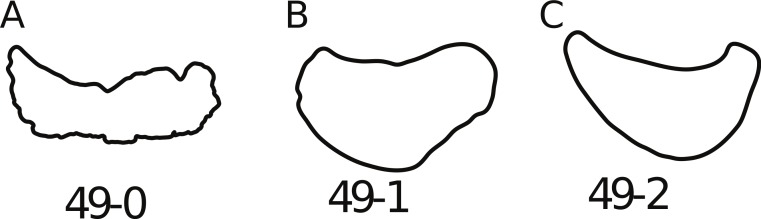
Articular surfaces of neosauropod quadrates.Quadrate articular surface shapes of Camarasaurus sp. SMA 0002 (A, quadrangular, C49-0), Suuwassea emilieae ANS 21122 (B, roughly triangular, C49-1), and Nigersaurus taqueti MNN GAD512-7 (C, crescent-shaped, C49-2). Figures of Suuwassea and Nigersaurus traced from Harris (2006a) and Sereno et al. (2007), respectively.